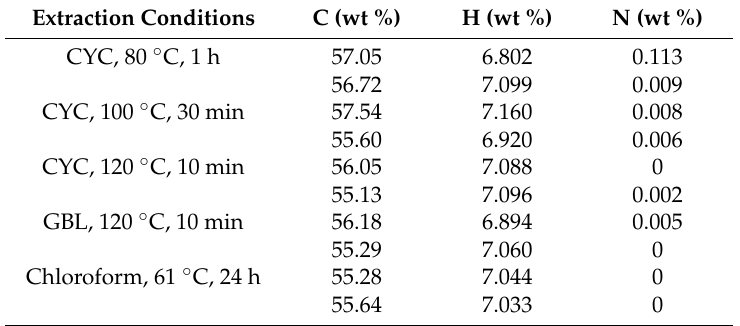
Table 1. Elemental analysis of the PHA extracted using non-chlorinated solvents. Two parallel measurements were conducted for each